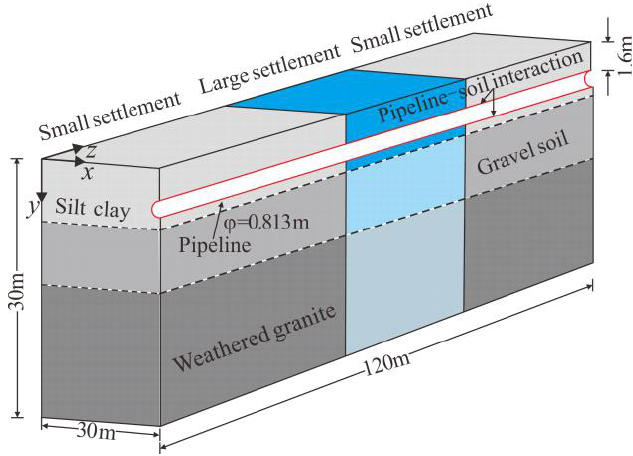
Figure 3. Model description of the buried pipeline-soil interaction.